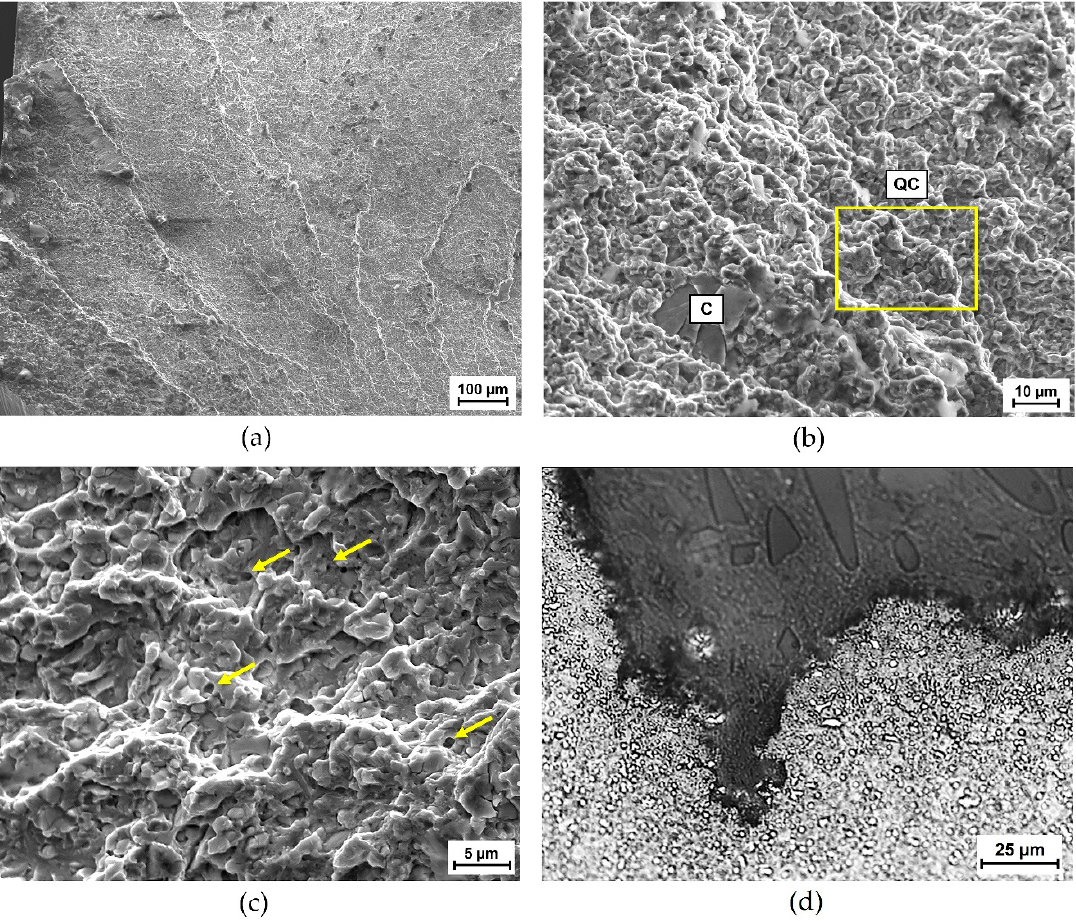
Figure 6. ( a – c ) SEI-SEM micrographs of the fracture surfaces of taps after tapping test showing, in the order, an overview of fracture surface, details of cleavage (C) and a quasi-cleavage (QC, yellow rectangle) region, and microvoids formed by decohesion of secondary carbides (yellow arrows); ( d ) optical micrograph of the fracture surfaces observed on the cross-sections of taps.